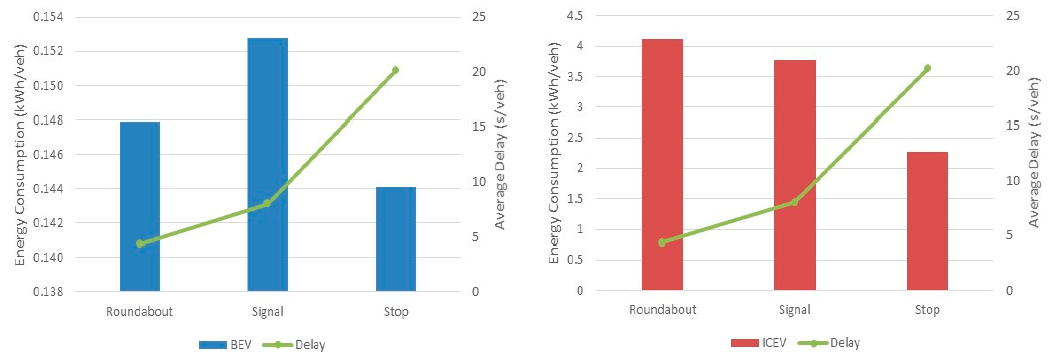
Figure 3. Comparison of BEV and ICEV energy/fuel consumption for different intersection control strategies (approach speed = 72 km/h).